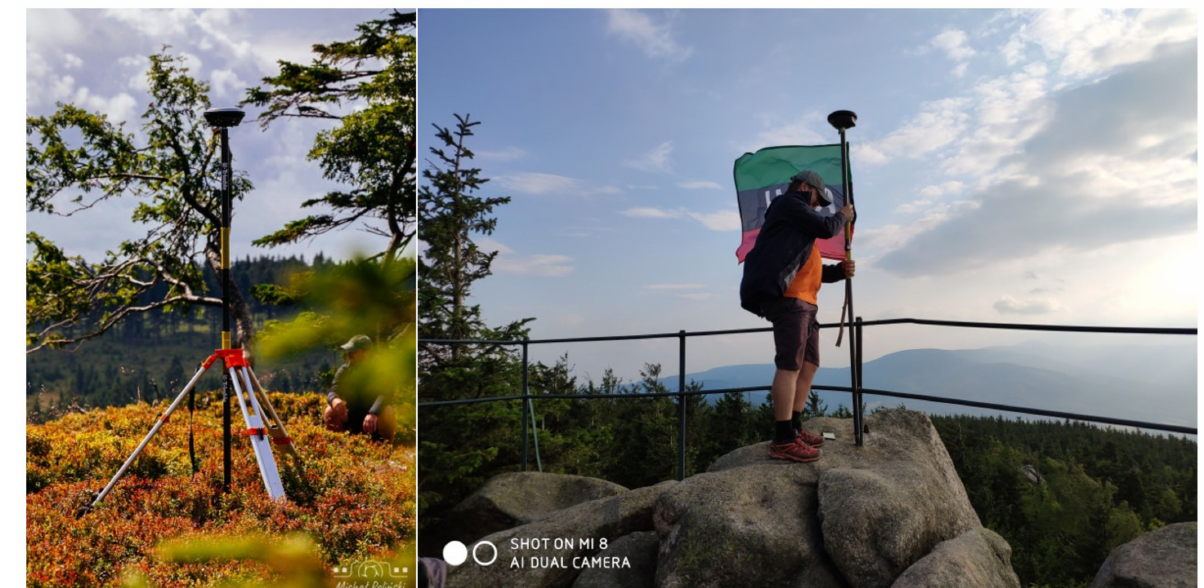
Figure 5. GNSS static session at Mount Brusek (the Złote Mountains, on the left) and RTK measurement at Mount Ostra Mała (the Rudawy Janowickie Mountains, on the right). Author: Krystian